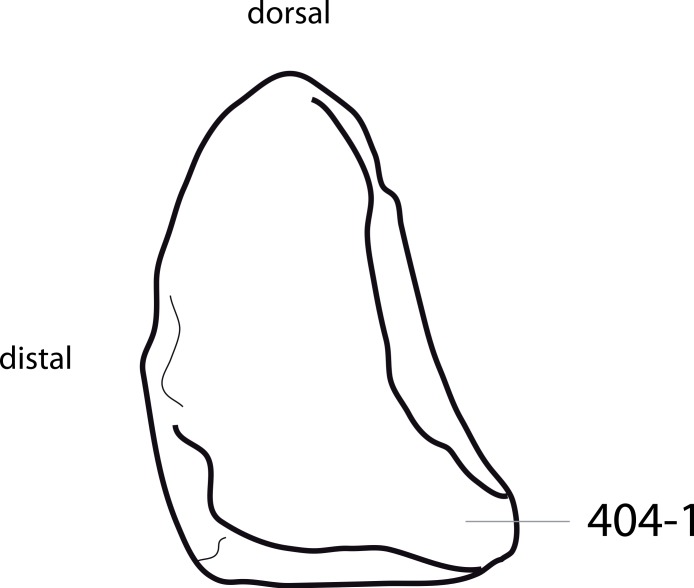
Manual phalanx phm I-1 of Apatosaurinae indet. NSMT-PV 20375 in medial view (traced from Upchurch, Tomida & Barrett, 2004).Note the proximoventral lip-like projection (C404-1).